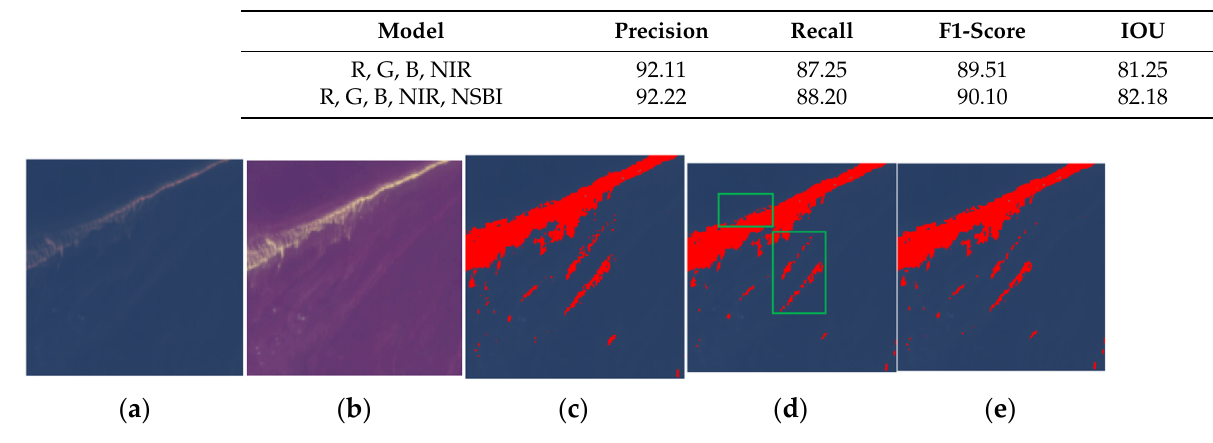
Figure 14. Influence of NSBI on the performance of NSB recognition. ( a ) RGB; ( b ) FRGB; ( c ) ground truth; ( d ) R, G, B, NIR; ( e ) R, G, B, NIR, NSBI.